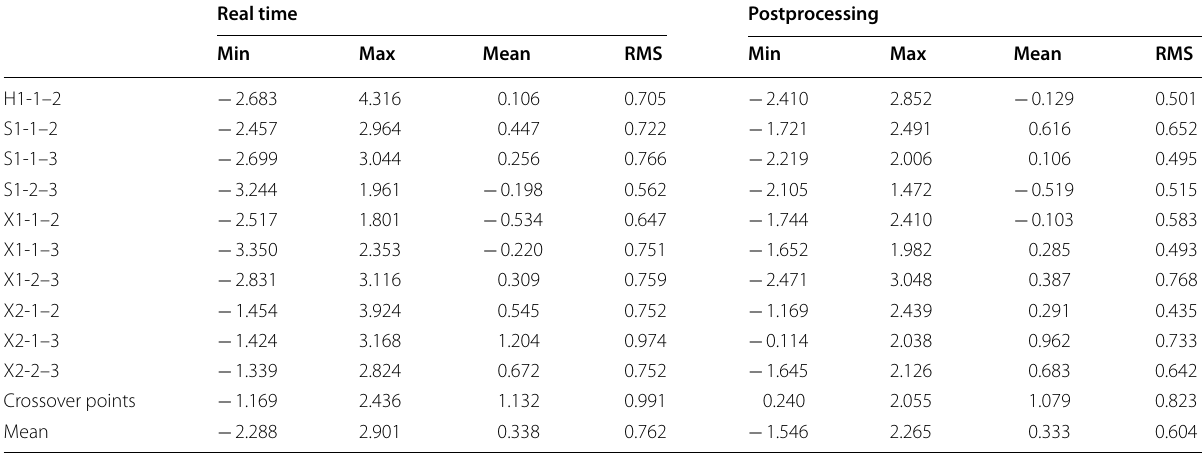
Table 7 Statistical results of SAG-2M (mGal)